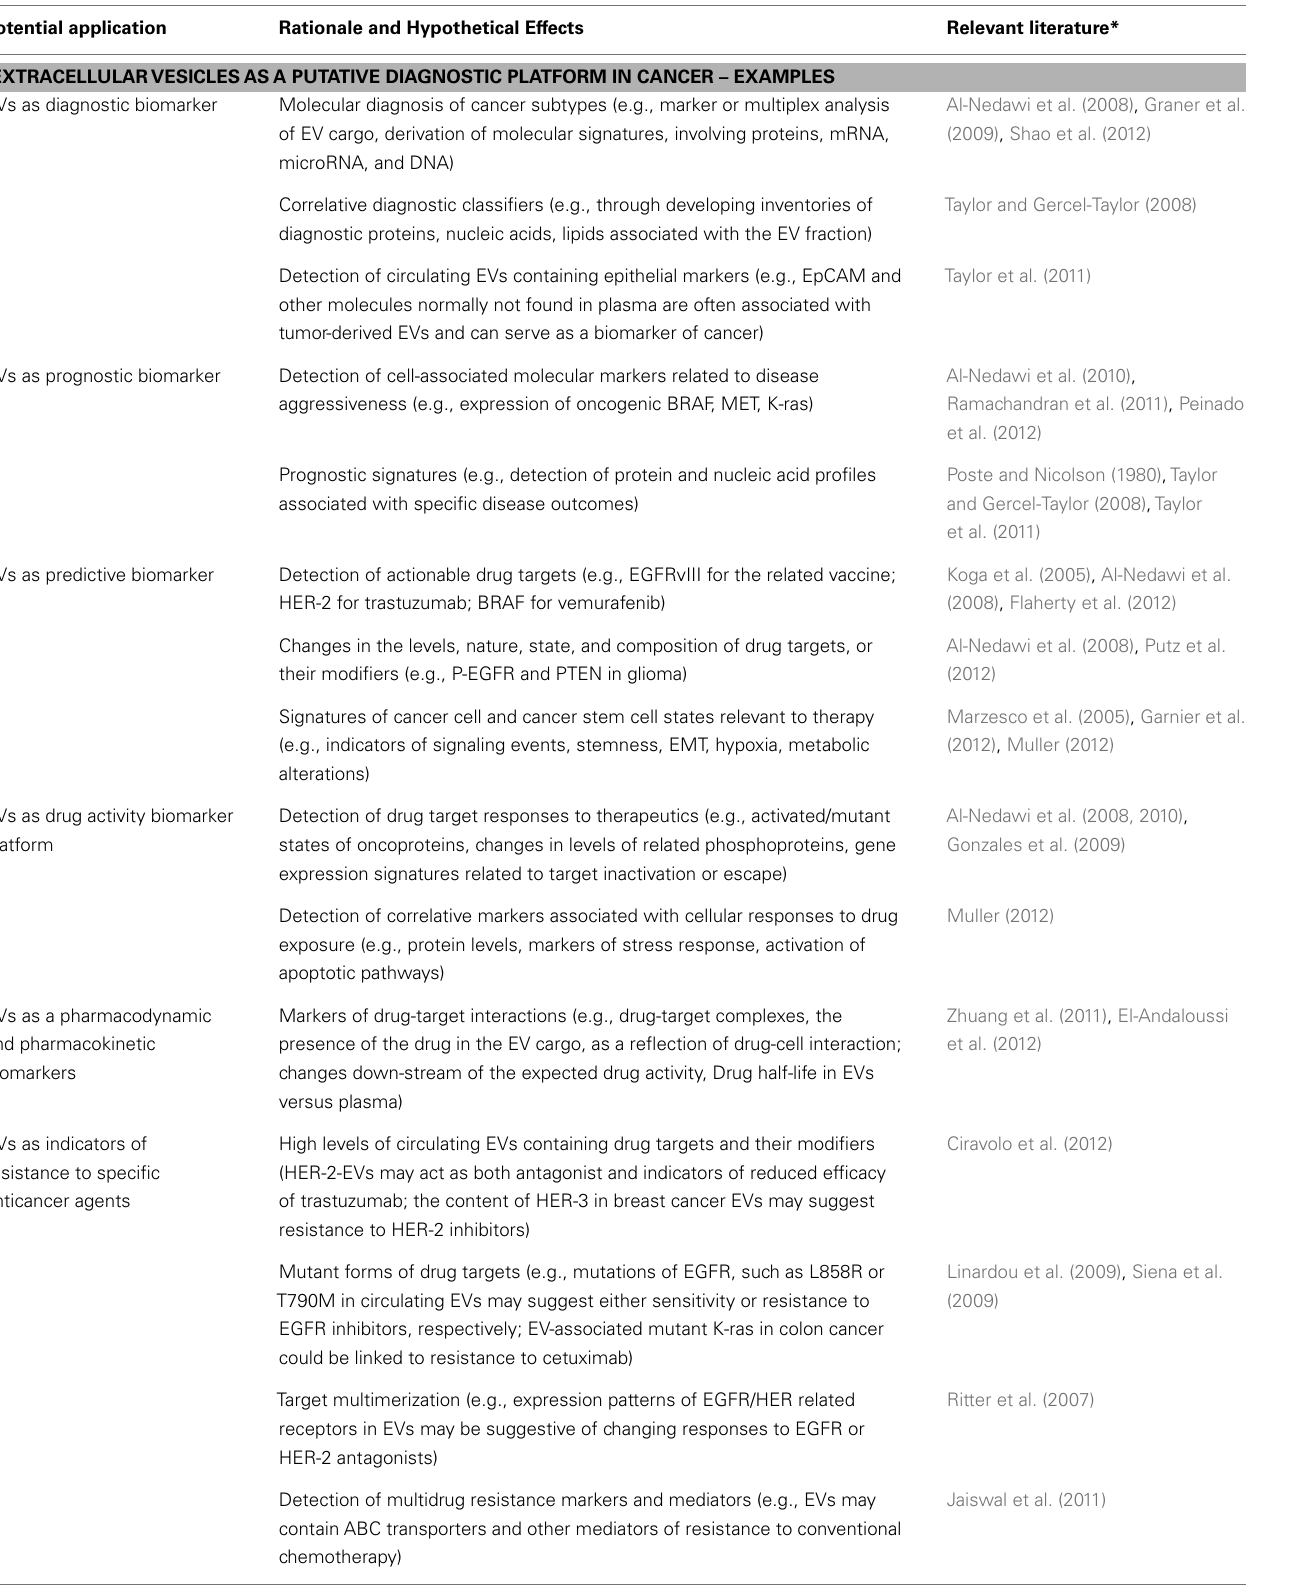
Table 1 | Possible applications of extracellular vesicles in cancer diagnosis and